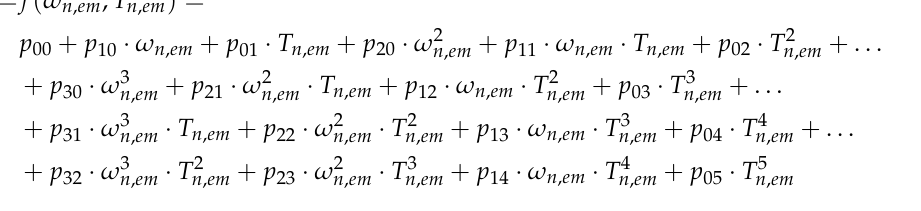
Figure 2. EM characteristics in motor mode. Original characteristics: ( a ) BMW i3; ( c ) Kia Soul; ( e ) YASA EM and normalized characteristics: ( b ) BMW i3; ( d ) Kia Soul; ( f ) YASA EM. η em = f ( ω n , em , T n , em )